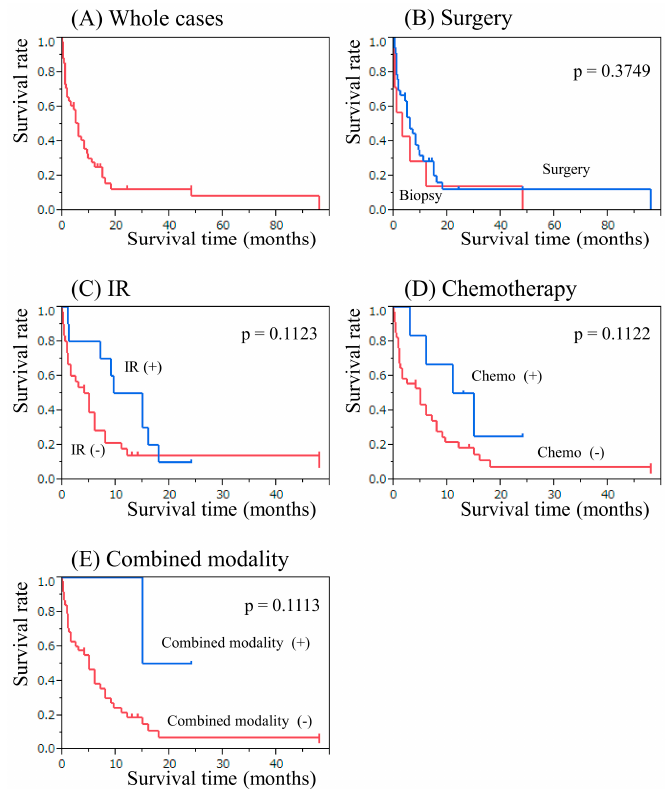
Figure 6. Kaplan-Meier survival analysis in patients with secondary sarcomas. ( A ) Whole cases. ( B )